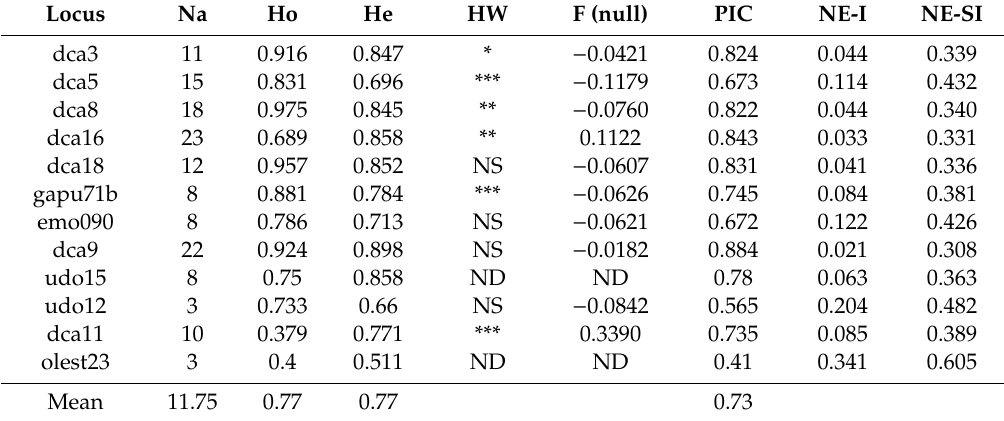
Table 2. Parameters of genetic diversity for each SSR marker.